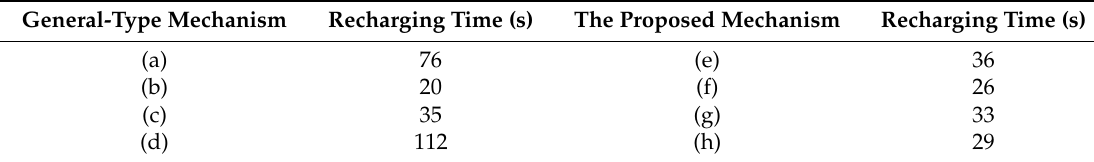
Table 13. Time spent in the first part of experiment.